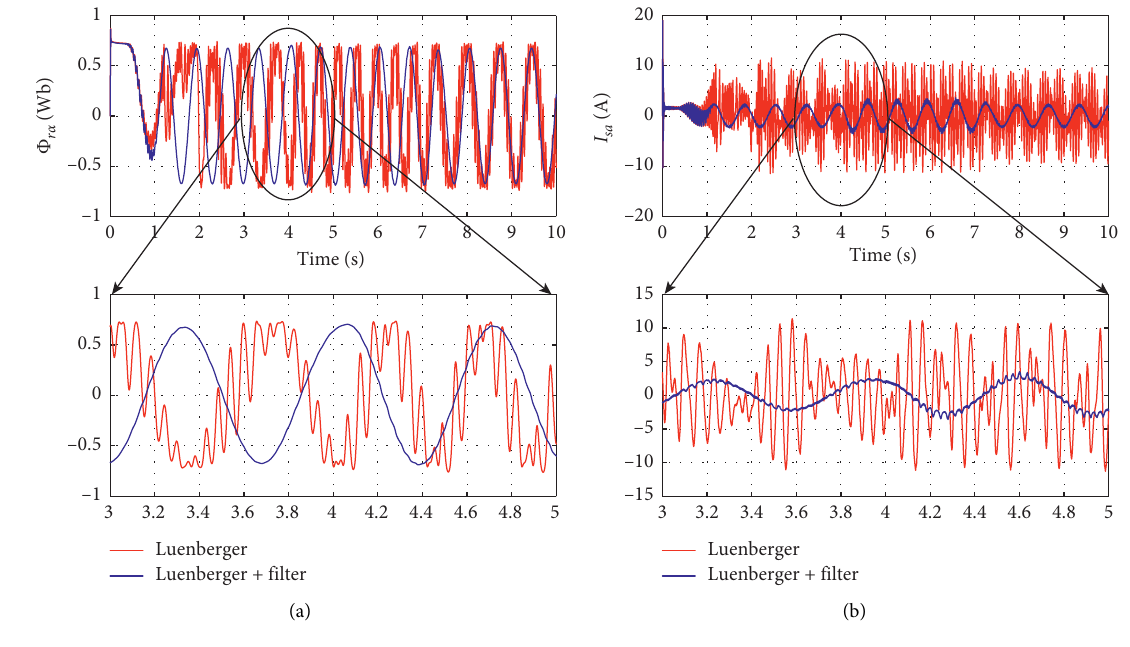
Figure 15: (a) α -axis rotor flux. (b) Stator